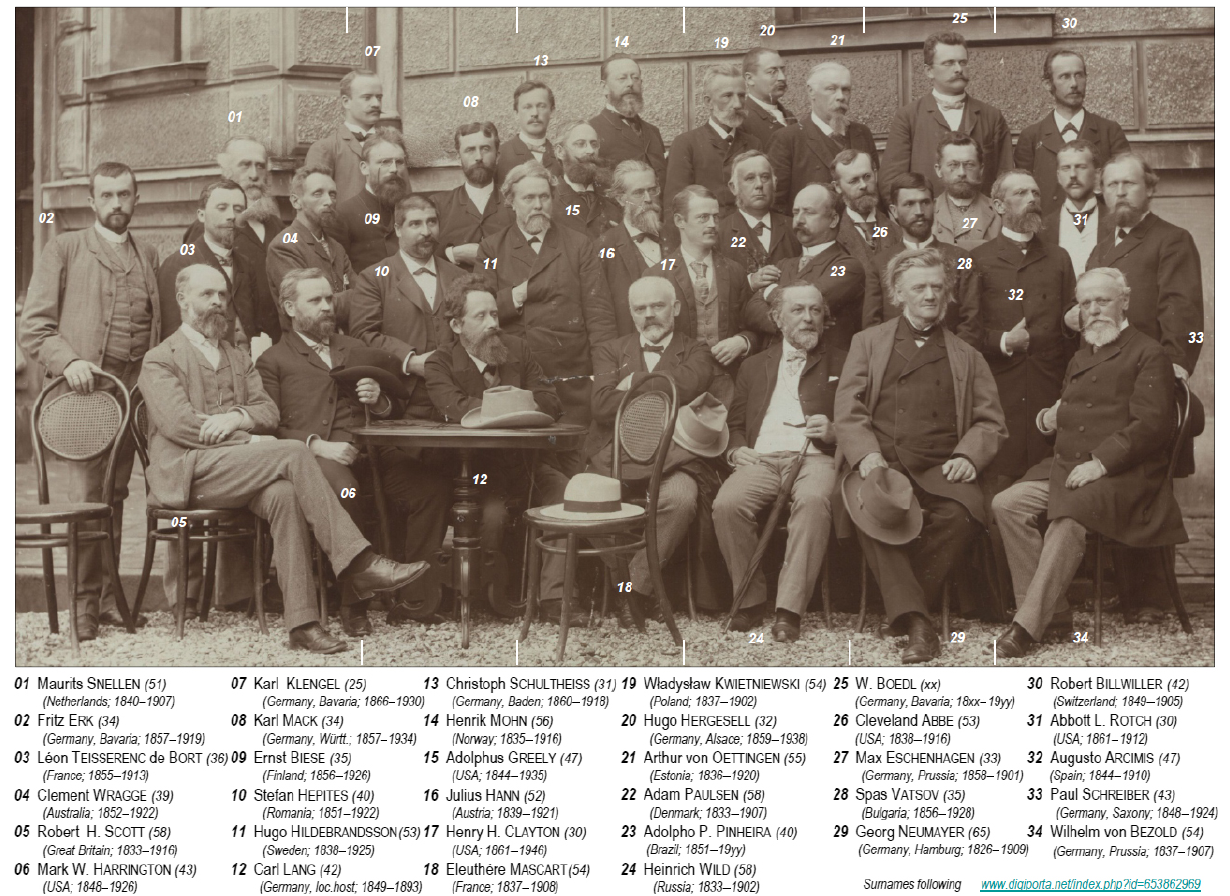
Figure 1. Participants at the International Conference of Directors of Meteorological Services, in Munich, Bavaria, Germany, 26 August– 2 September 1891, 28 years prior to the formation of the Section of Meteorology. Numbering is in six columns, from left to right, with the following information for each person: number, first name, surname (age at conference, representative for country or state, and lifespan). The surnames follow the handwritten note attached to the copy kept at Deutsches Museum, Digitales Porträtarchiv, Munich, Germany (cf. website http://www.digiporta.net; last access: 25 January 2019). The high-resolution scan was provided by the National Meteorological Library and Archive in Exeter,